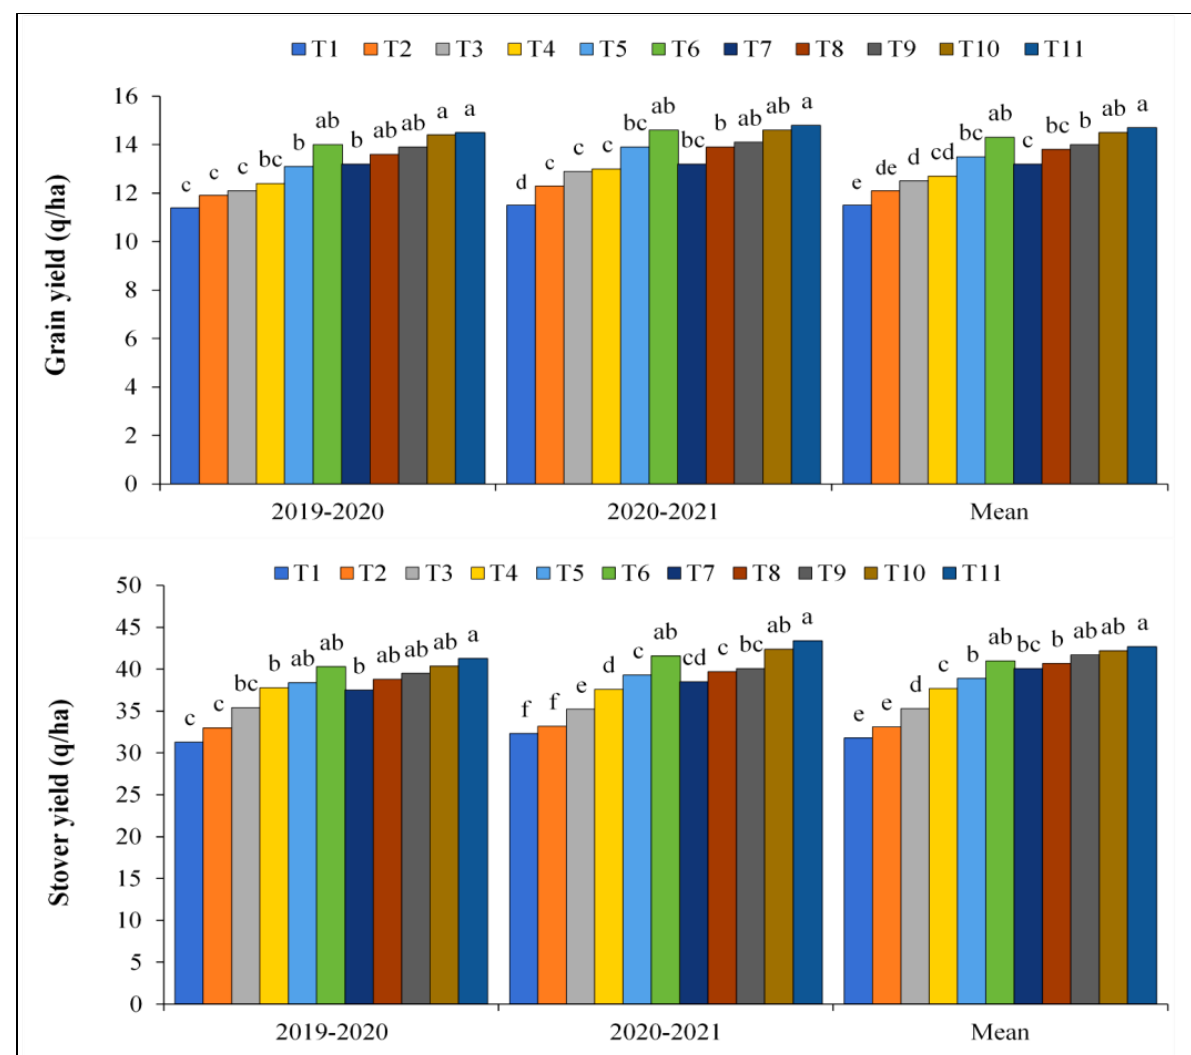
Figure 2. Effect of urea and micronutrient foliar spray on grain and stover yield (q ha − 1 ) of Indian mustard. Treatments details are available in Table 1. The bar with a similar or dissimilar letter(s) was evaluated with the least significant difference (LSD) multiple range tests using a probability level of p ≤ 0.05.